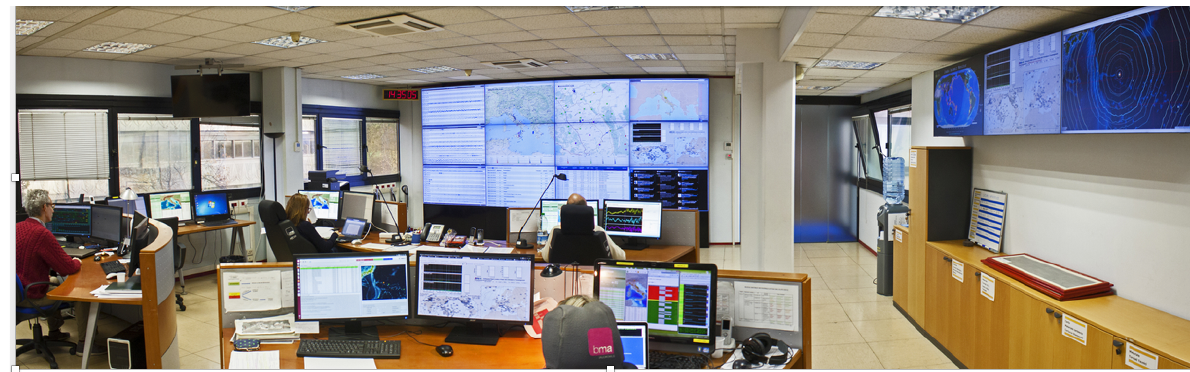
Figure 6. Surveillance, operational room in